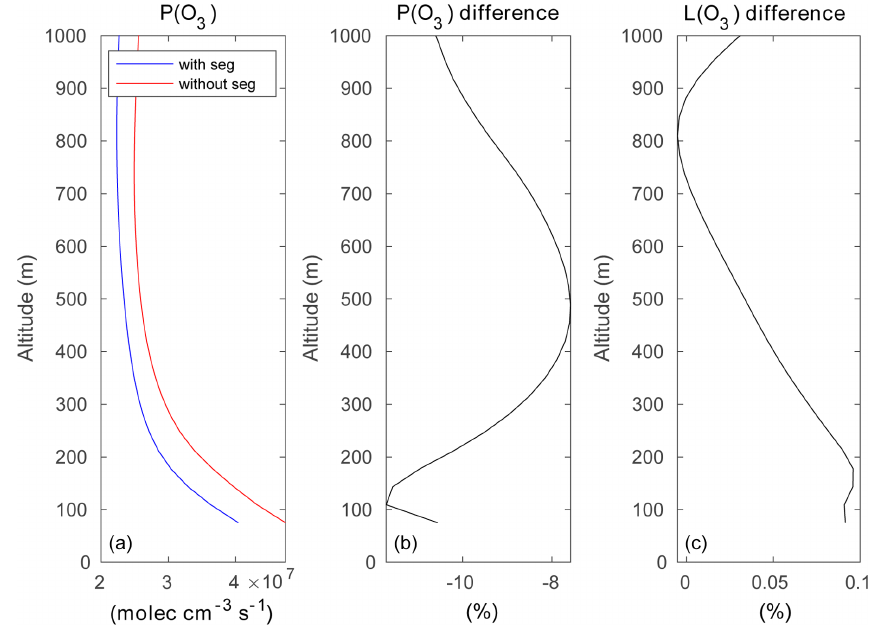
Figure 16. (a) Vertical distribution of the ozone production rate (molec.cm − 3 s − 1 ) averaged over the central 14 × 14km 2 of the inner domain, with the effect of segregation taken into account (blue curve) or ignored (red curve). (b, c) Percentage difference between the two cases for the photochemical production and destruction